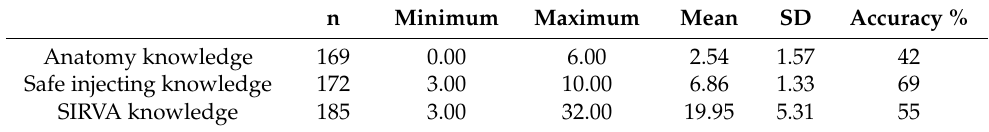
Table 2. Pooled knowledge scores for shoulder anatomy, safe injecting, and SIRVA. n Minimum Maximum